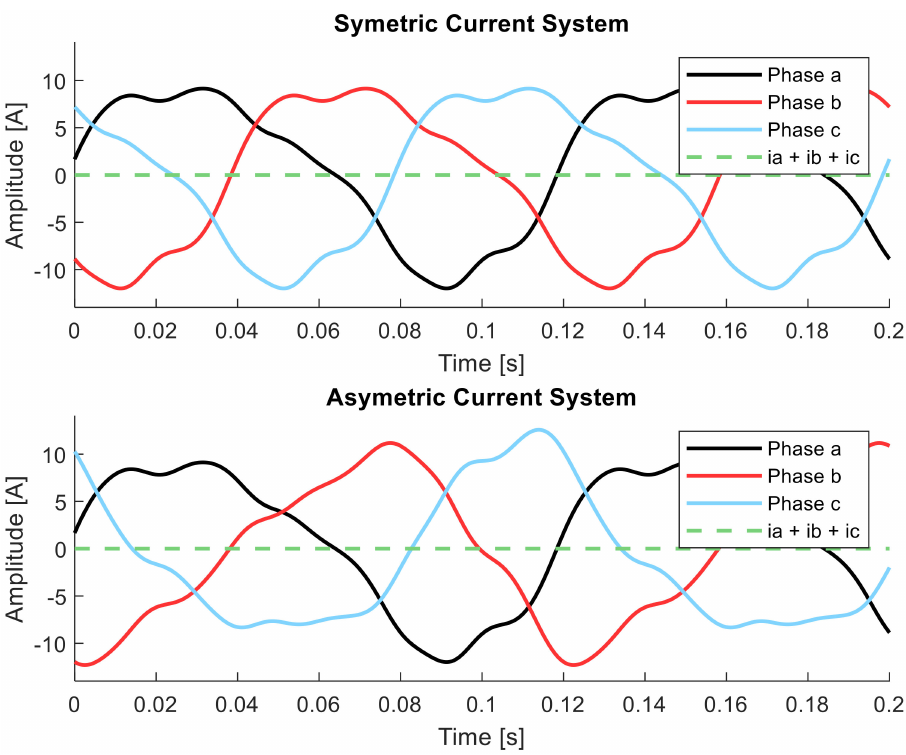
Figure 1. Symmetrical and asymmetrical current system in